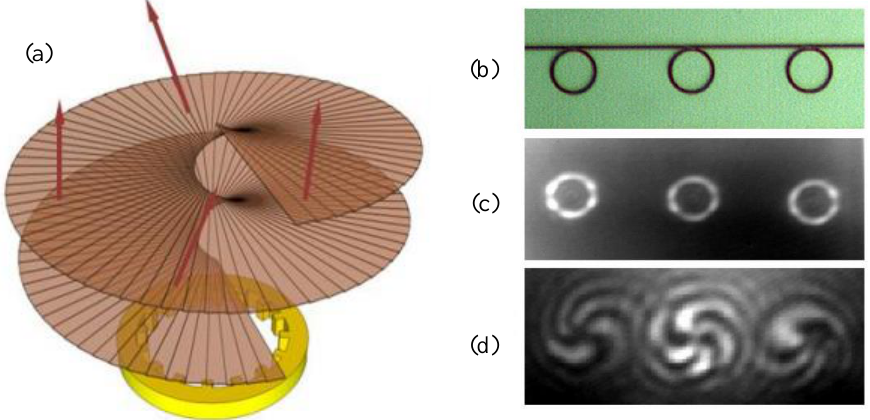
Figure 23. ( a ) Schematic diagram of the angular grating and the helical wave-front of the radiated beam. ( b ) The microscopic diagram of the integrated device. ( c ) The intensity distributions of the vortex beams (l = − 3) generated by the integrated device. ( d ) The corresponding interference patterns between the vortex beam and the right-hand circularly polarized Gaussian beam (Adapted from an open-access source Ref. [131]).